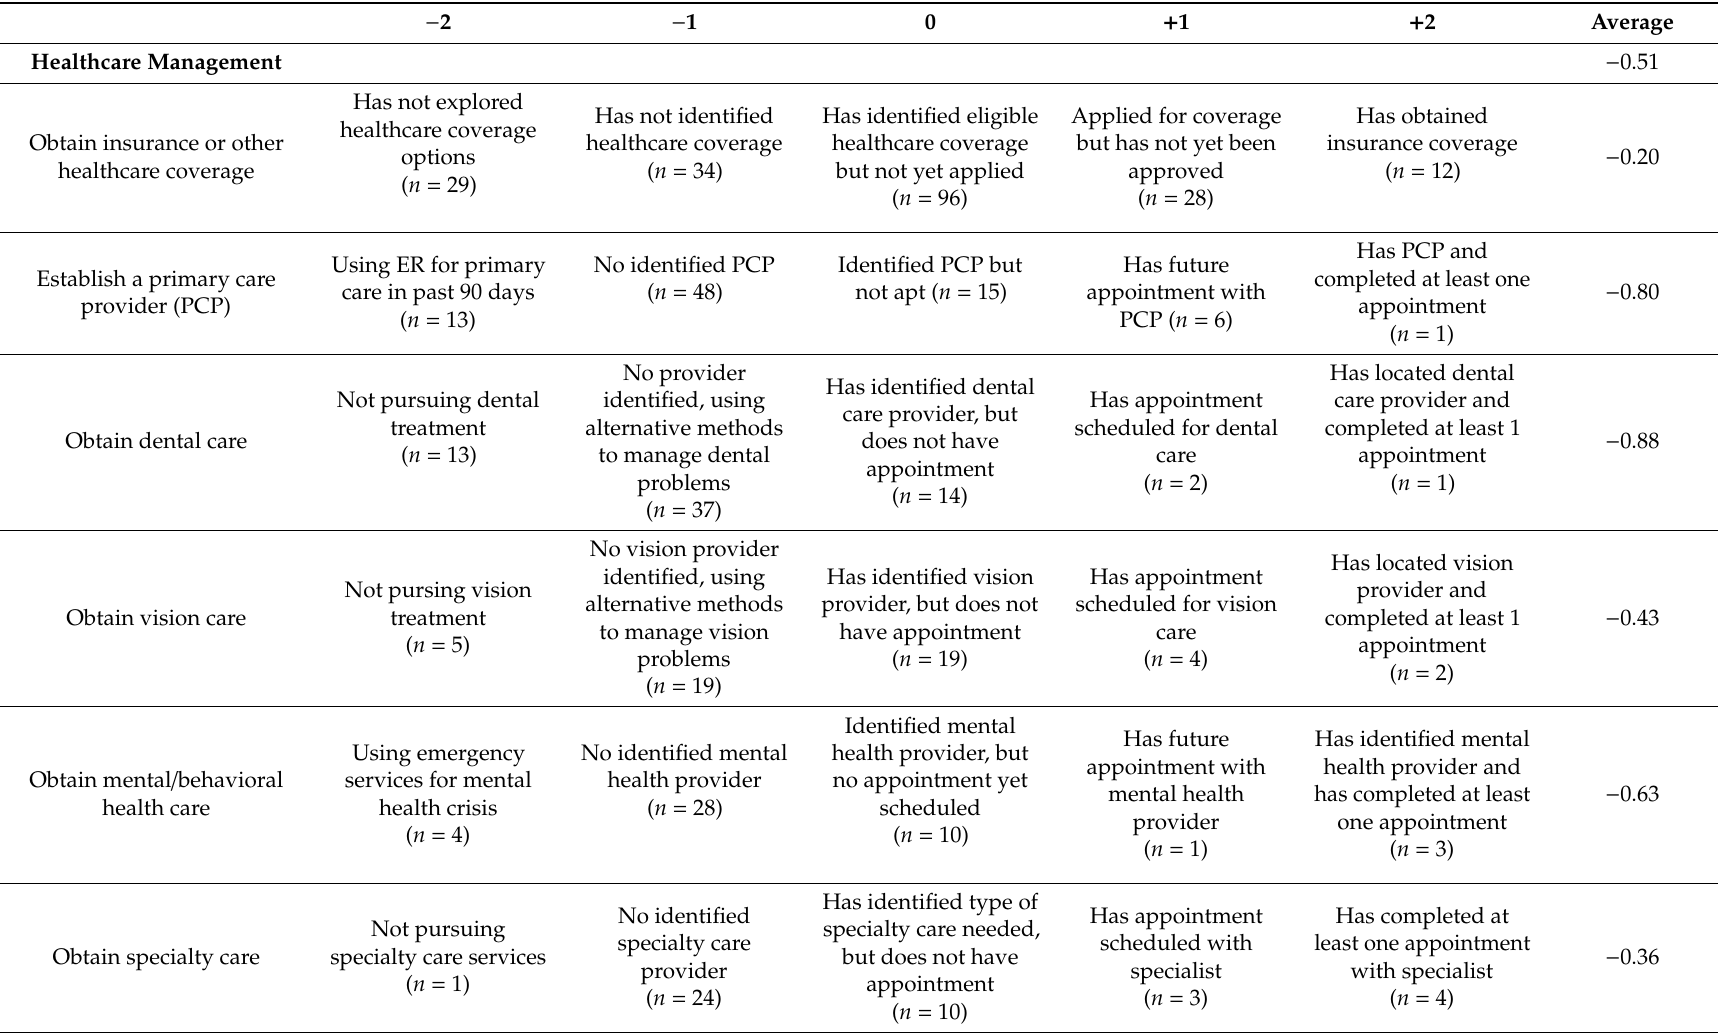
Table 3. Description of the goal attainment scale by the goal and number of clients selecting the baseline goals. − 2 − 1 0 + 1 + 2 Average